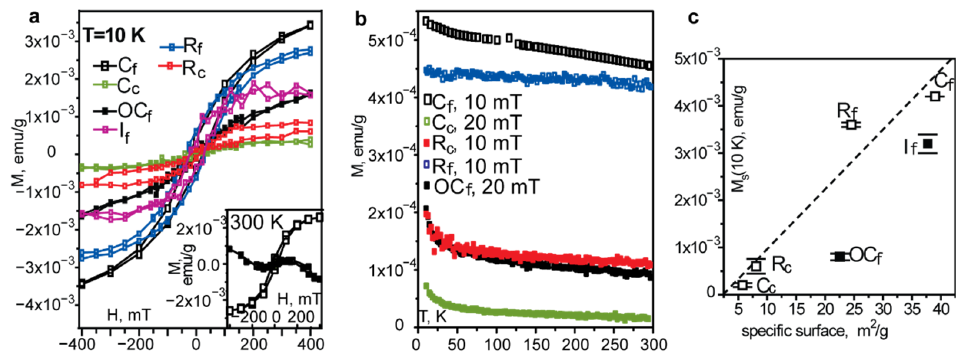
Figure 4. ( a ) Magnetization loops at T = 10 K and at 300 K (Insert), ( b ) temperature dependence of the magnetization, and ( c ) saturation magnetization on specific surface area at 10 K for reduced (open squares) and oxidized (solid squares) powders. Lines are only guides for the eye.